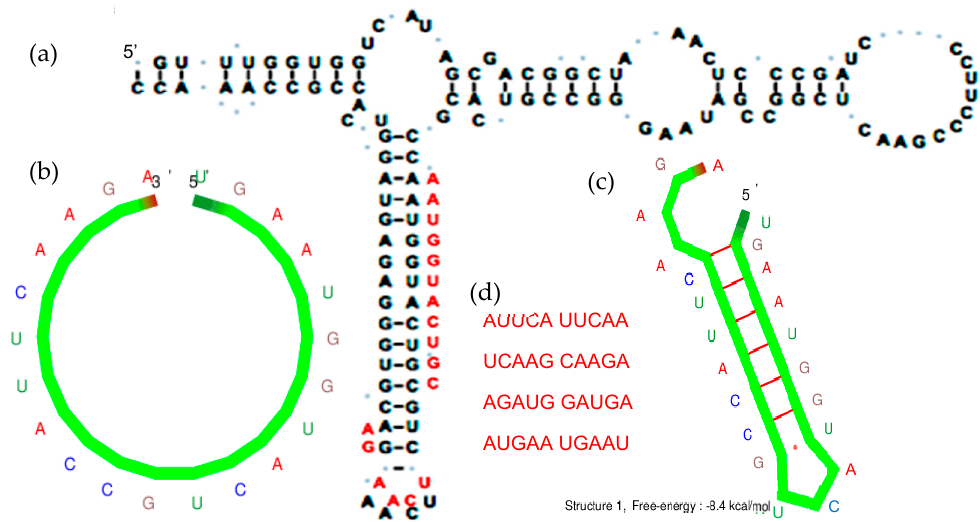
Figure 1. ( a ) AL hemi-sequence AAUGGUACUGC (in red) and AL-hexamer UCAAGA (in red) in a stem of the 5S rRNA of Rhodobacter sphaeroides [38]. ( b ) Ring form of AL. ( c ) Optimal hairpin form of AL (obtained using Kinefold ® [47]). ( d ) Most likely pentamers observed after denaturation of the hairpin form of AL, called most plausible observed pentamers or p-pentamers.